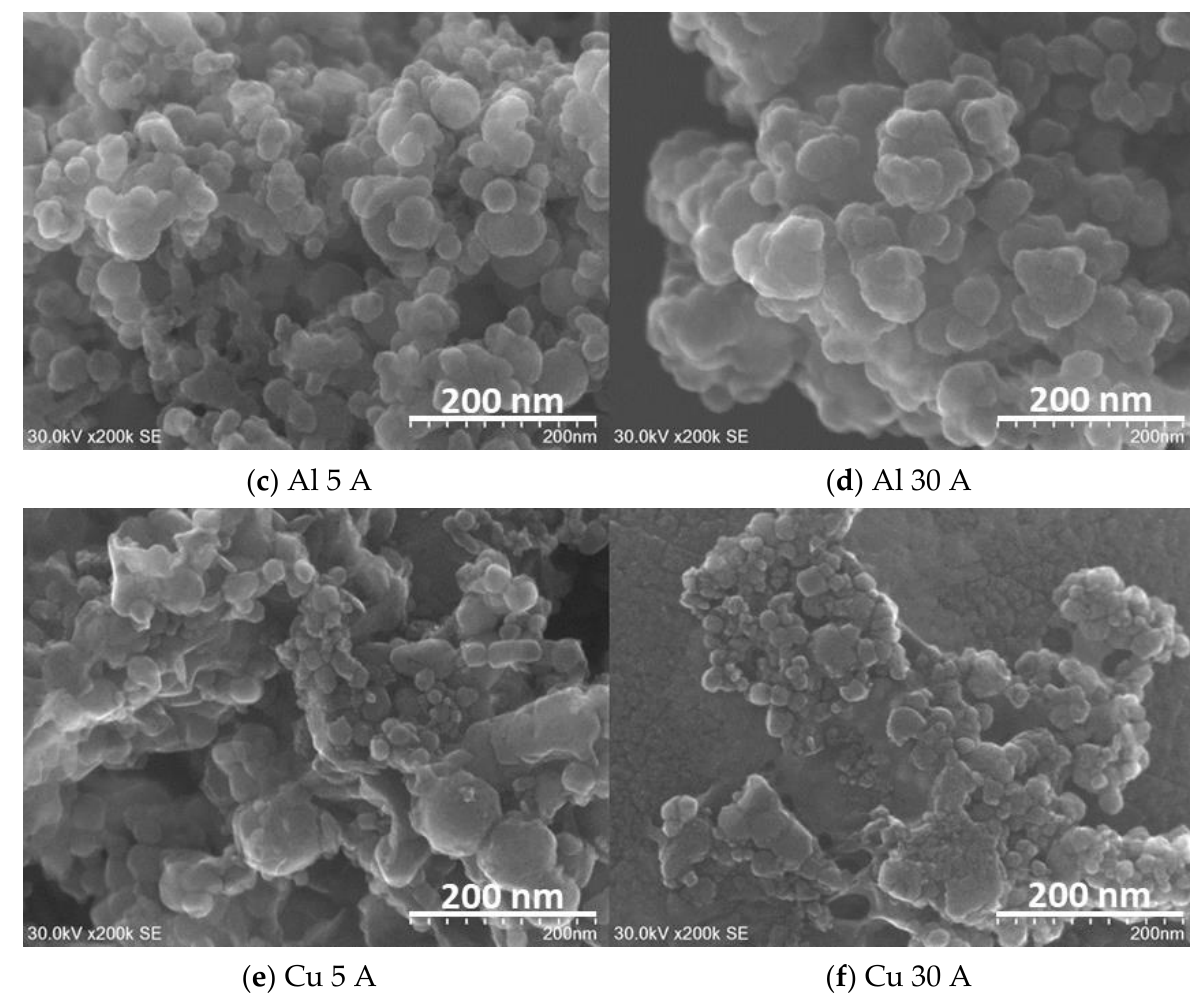
Figure 3. FE-SEM (SU9000) images of the prepared nanoparticles using ( a , b ) Ti, ( c , d ) Al, and ( e , f ) Cu electrodes at a current of 5 and 30 A. Detailed descriptions are placed below in each panel.